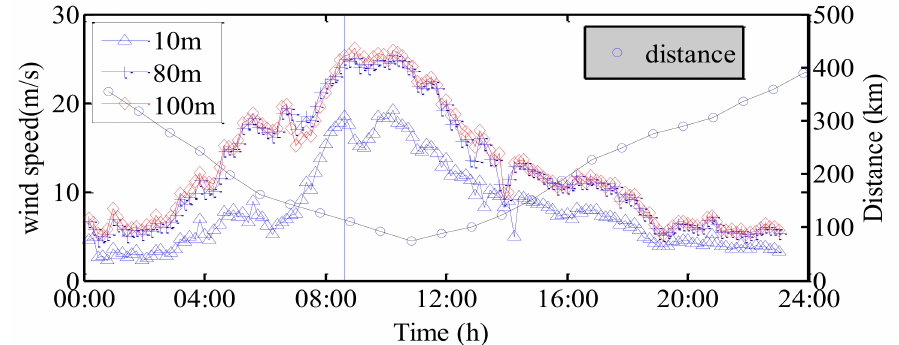
Figure 6. The 10-min mean wind speed during Typhoon “Maria”.